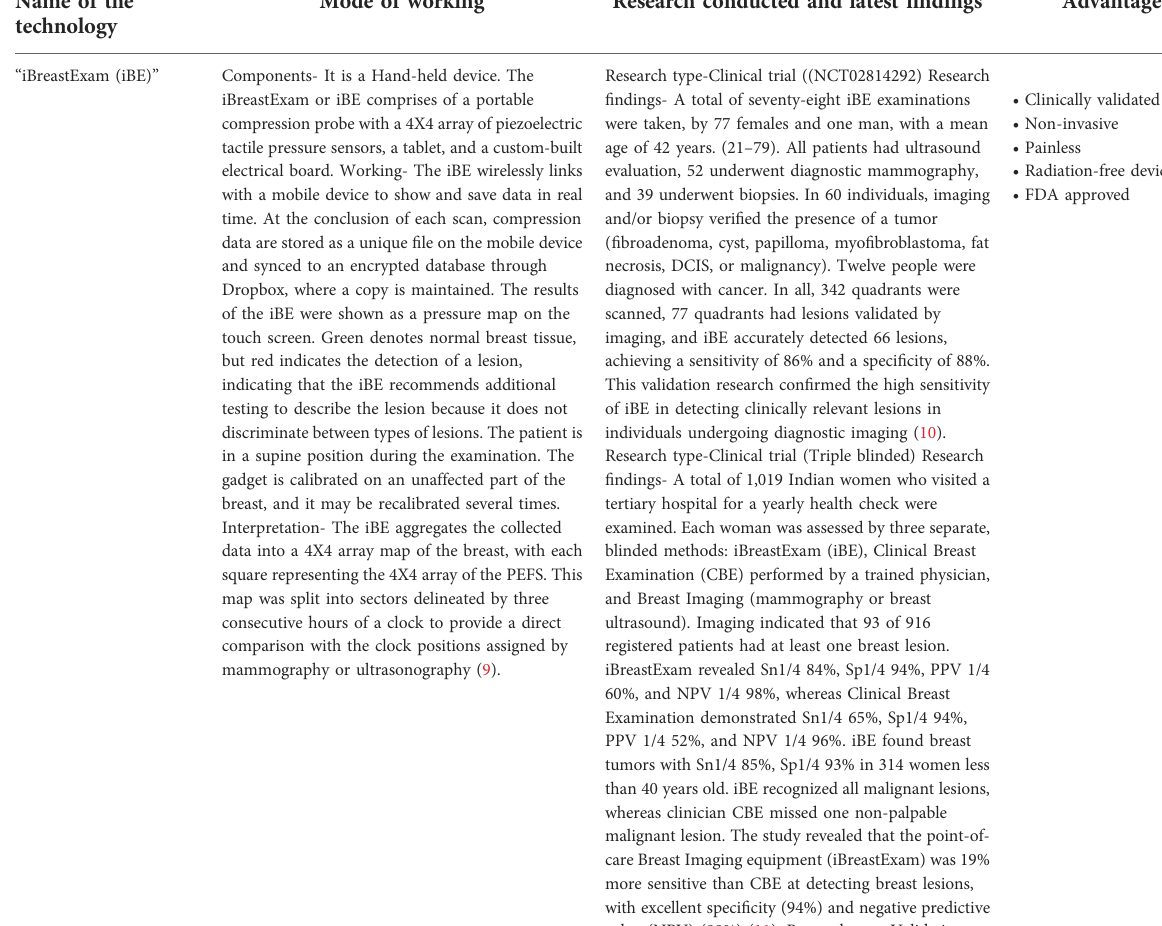
TABLE 1 Ai based technologies used for early detection of breast cancer. Name of the